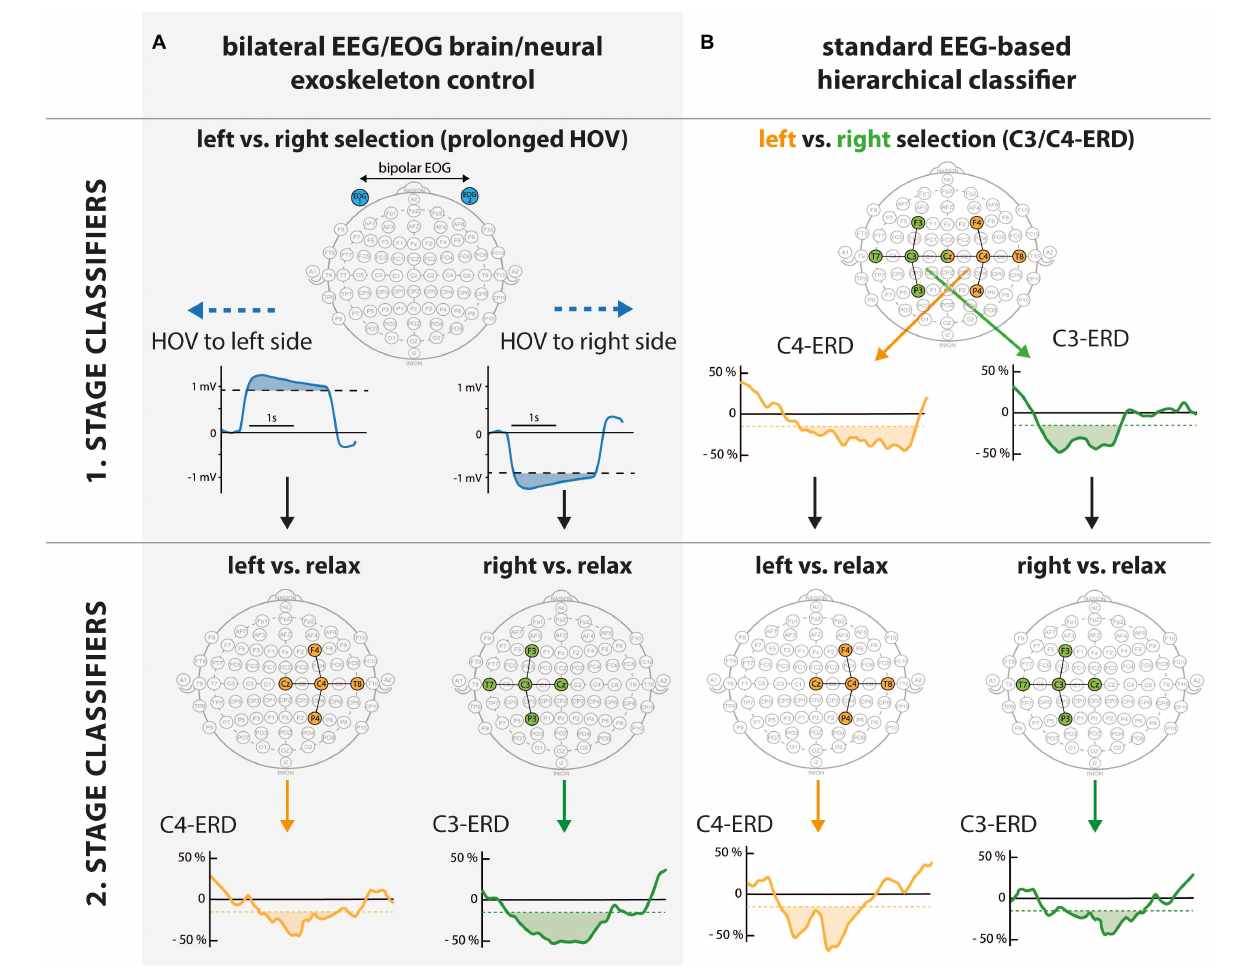
FIGURE 4 | Hierarchical structure of bilateral electroencephalography/electrooculography (EEG/EOG) brain/neural exoskeleton control ( A , gray shaded area) vs. standard EEG-based hierarchical classifier ( B ). While the user could select the left vs. right side at the first stage, closing vs. rest was classified at the second stage. Comparison of first stage classifiers: By using prolonged horizontal oculoversions (HOVs) to the left or right based on bipolar EOG (blue electrodes laterally placed to outer canthi), the subsequent classifiers at the second stage were activated. The solid blue line shows prolonged HOV signals exceeding the detection threshold for > 1 s (blue shaded area). In contrast, a standard EEG-based hierarchical classifier requires distinct lateralization of event-related desynchronization (ERD) to C3 and C4. A common approach evaluates Laplace-filtered C3-ERD (green electrodes) and C4-ERD (orange electrodes) to classify the left vs. right side. To activate the left side (left branch), contralateral sensorimotor rhythm (SMR)-ERD at C4 (solid orange line) exceeding the C4-ERD detection threshold (orange shaded area) is needed. To select the right side, SMR-ERD at C3 (C3-ERD) needs to be detected accordingly (right branch). Second stage classifiers: At this stage, left/right vs. relax is distinguished. Depending on the classification at the first stage, electrodes of only one hemisphere are activated (green or orange electrode sites). Solid orange/green line shows valid C4-/C3-ERD (orange/green shaded areas). In case C4/C3-ERD detection thresholds were not exceeded, a relax state was detected. This classifier stage is identical for both